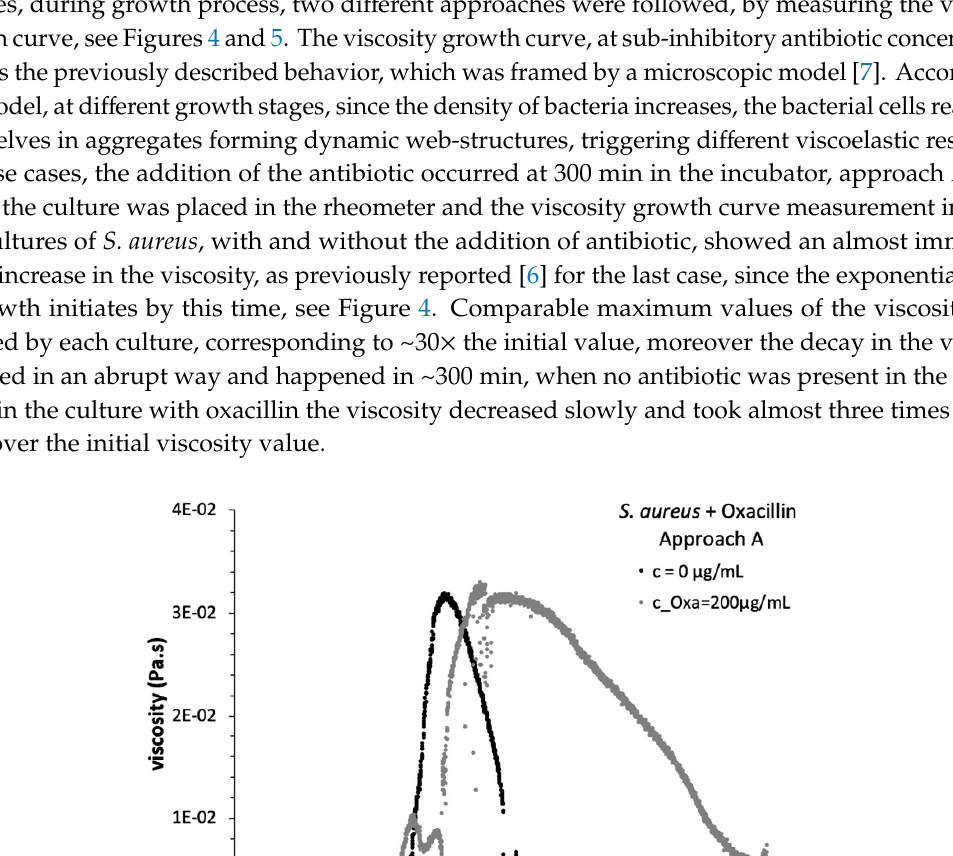
Figure 5. Viscosity growth curves for bacterial cultures of S. aureus , with the addition of the antibiotic oxacillin directly to the sample in the rheometer, approach B. The bacteriolytic antibiotic oxacillin was added at t = ~340 min for two concentrations: c_Oxa = 200 µg/mL (full gray symbol) and c_Oxa = 800